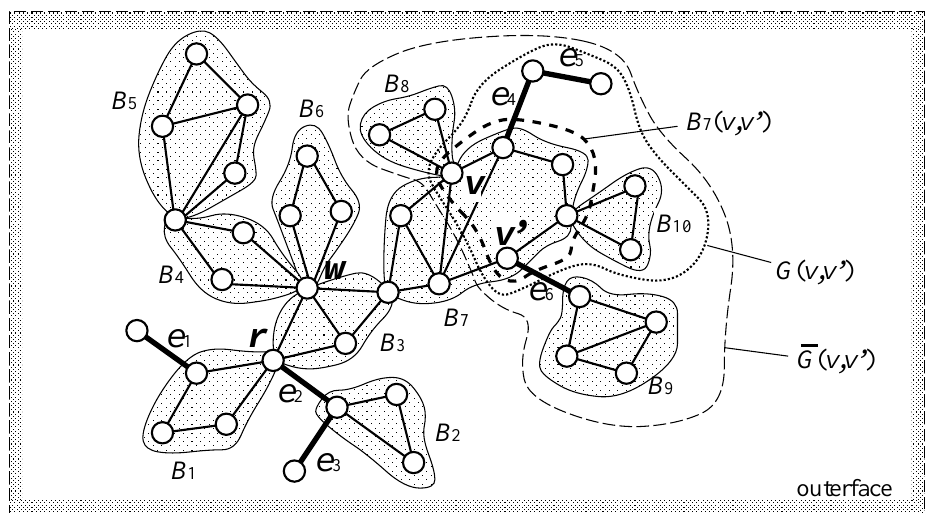
Figure 1. Example of an outerplanar